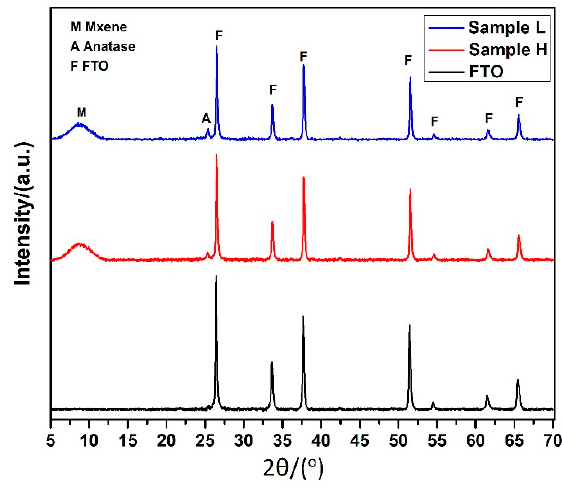
Figure 6. XRD spectra of bare FTO, Sample H, and Sample L.